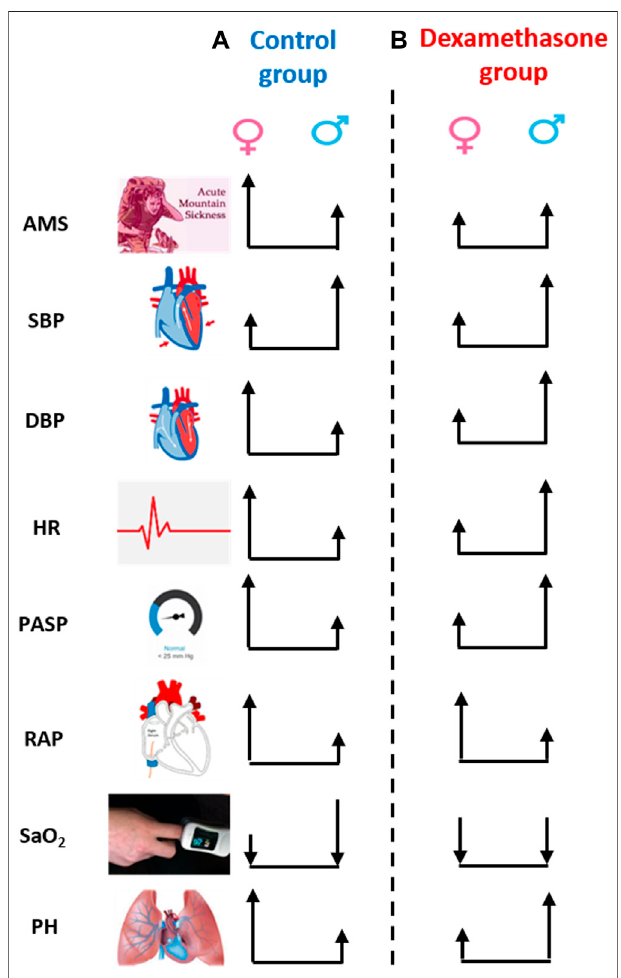
FIGURE 5 | Sex-biased clinical regulation by dexamethasone at high- altitude.Theheightofarrowrepresentsthenumericalchangeintherespective parameter on moving from low-altitude to high-altitude, and the upside and downside direction represents the increase or decrease, respectively. (A) Change in parameters, except for SBP and SaO 2 , was more evident in women than in men in the control group, that is, women were more susceptibletohigh-altitude. (B) However,thechangeinparameter,exceptfor RAP, was less in women than in men in the dexamethasone group. Dexamethasone controlled DBP, HR, and PASP more effectively and prevented AMS and PH at HA in women. AMS, acute mountain sickness; SBP, systolic blood pressure; DBP, diastolic blood pressure; HR, heart rate; PASP, pulmonary arterial systolic pressure; RAP, right atrial pressure; SaO 2 , arterial oxygenation; PH, pulmonary